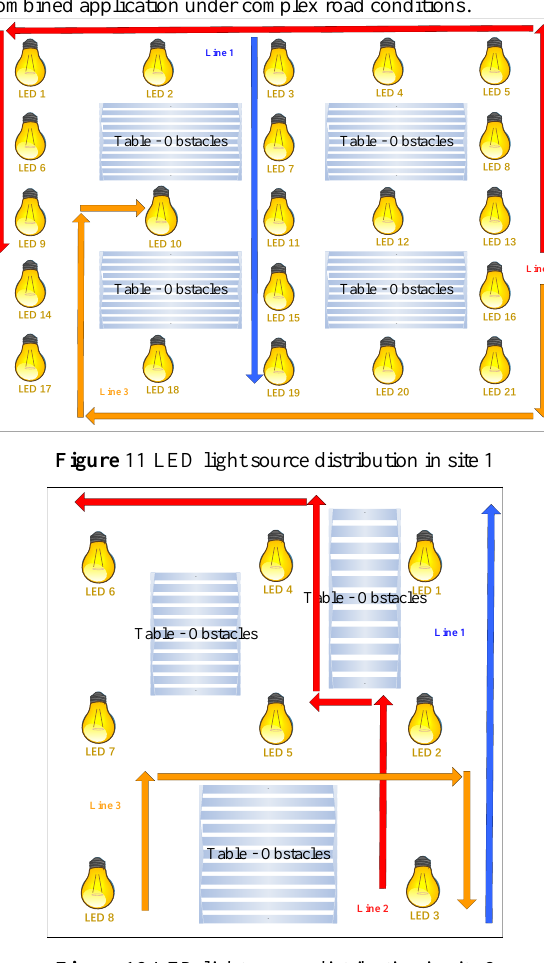
Figure 12 . LED light source distribution in site